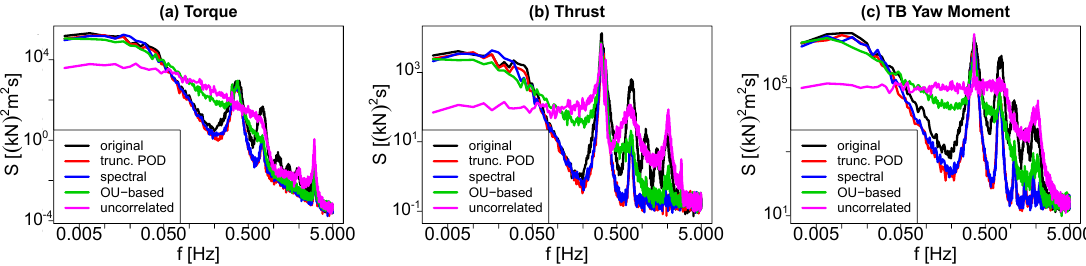
Figure 17. PSDs of the different loads for original LES and the different wake descriptions using N = 6 POD modes. Note that we aim to capture the behaviour of truncated PODs here, as pointed out in the beginning of this